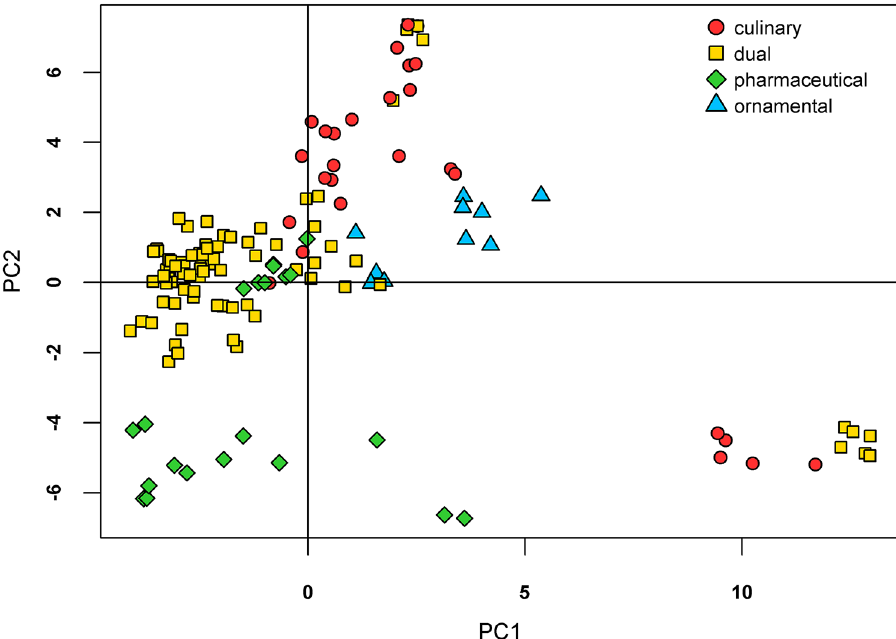
Figure 3. Exploratory analysis via PCA. The projection of two synthetic variables (PC1 and PC2) onto the factorial plane is shown. Created in R v4.0.3 (https:// cran.r- proje ct. org/) 23